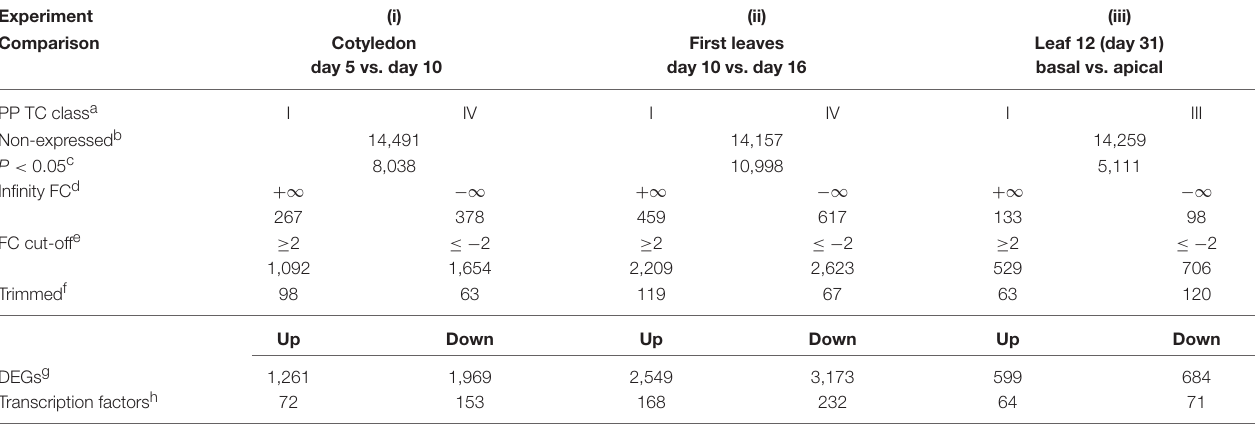
TABLE 1 | Summary of total gene numbers, DEGs, transcription factors and related statistics derived from RNA-Seq analysis of the three experimental comparisons of wall ingrowth deposition in PP TCs. Experiment Comparison